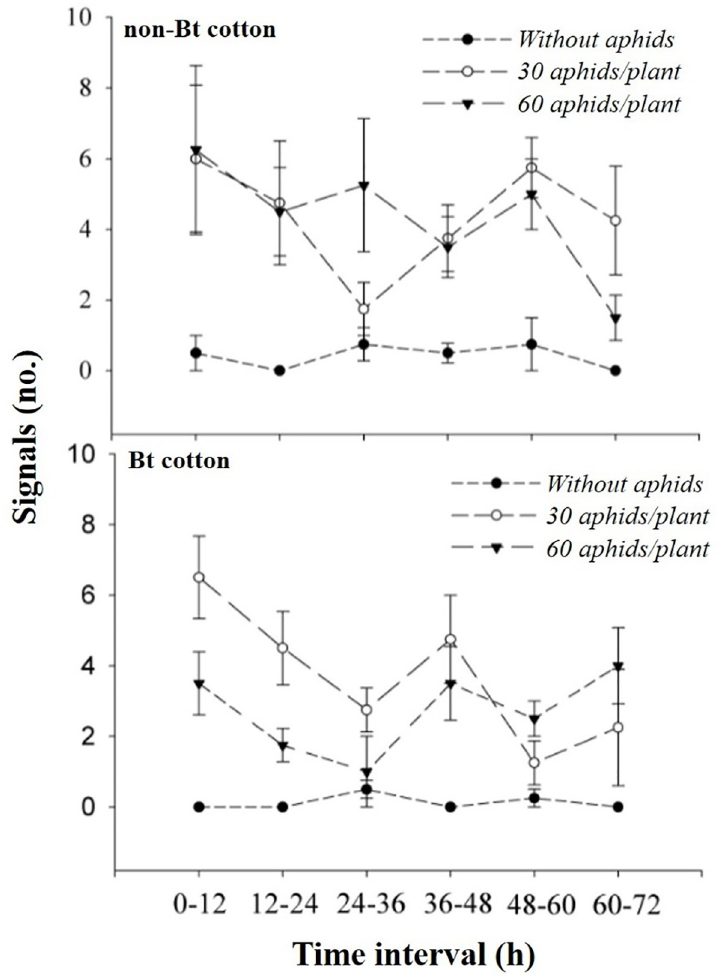
Fig 4. Variation potentials emitted (no.) (MEAN ± SE) by Bt and non-Bt cotton plants at different time intervals (h) after infestation of 30 and 60 aphids / plant and control (absence of aphid). Mean data (points) and error bars (SE) predicted by the generalized linear quasi-Poisson model, except for the plotted values for the control used in both cotton varieties (Bt or not Bt).